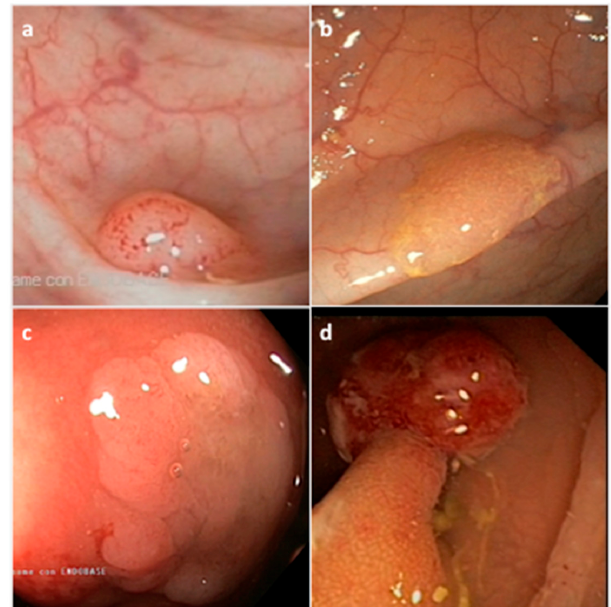
Figure 2. Representative endoscopic appearance of serrated lesions of the colorectum. ( a ) Hyperplastic polyp; ( b ) Sessile serrated adenoma / polyp; ( c ) Sessile serrated adenoma / polyp with